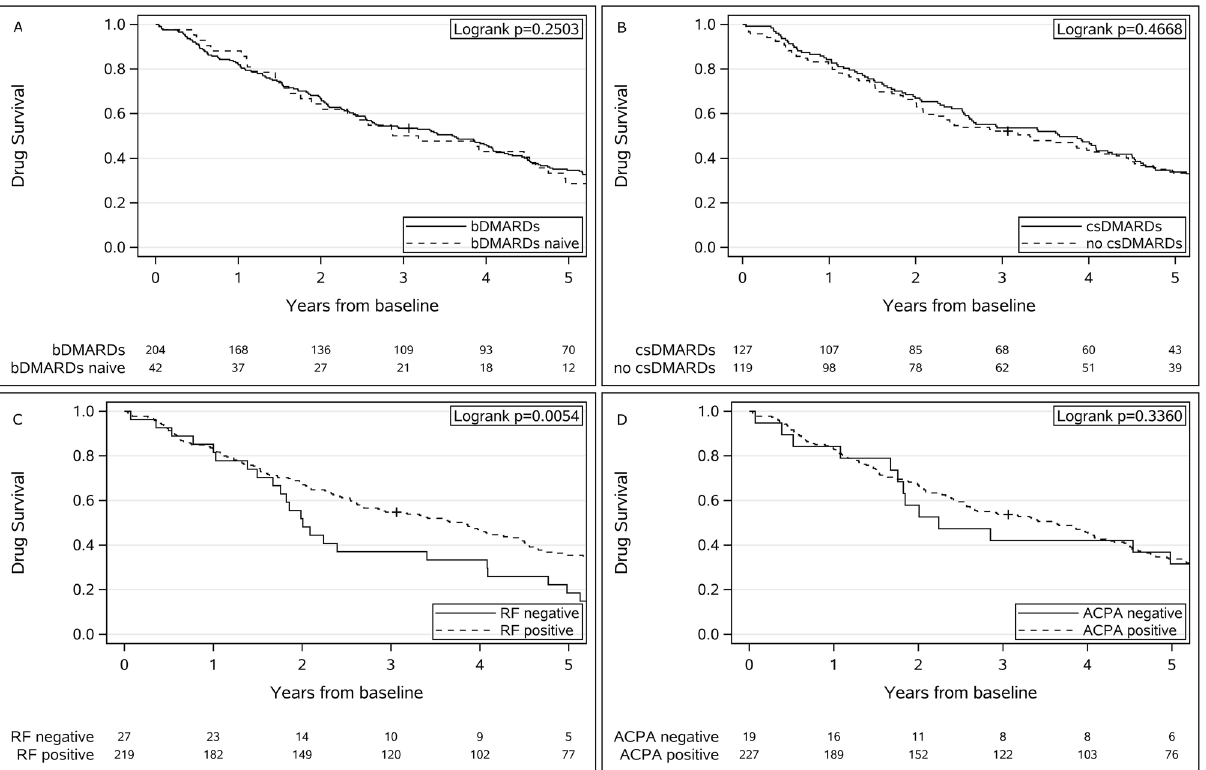
Figure 2. Kaplan–Meier plots of treatment retention rates among rheumatoid arthritis outpatient clinic patients treated with reference rituximab comparing ( A ) naïve and nonnaïve to bDMARDs, ( B ) concomitant and nonconcomitant users of csDMARDs, ( C ) RF positive versus RF negative and ( D ) ACPA positive versus ACPA